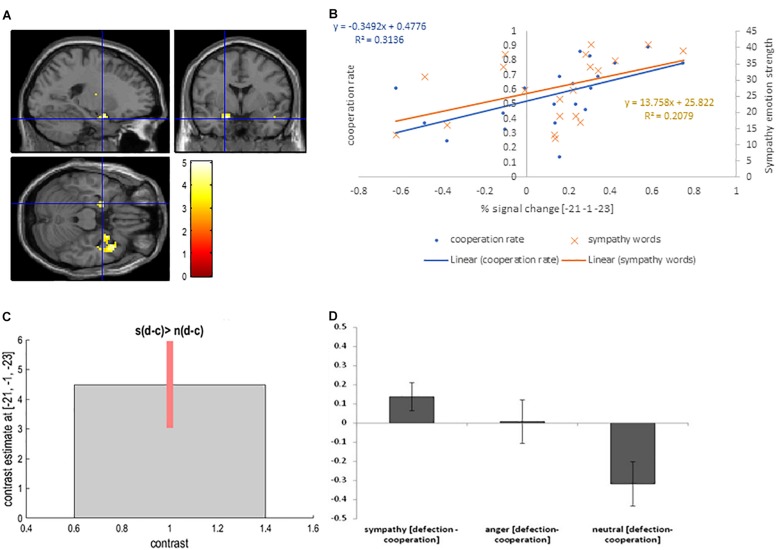
(A) Bilateral putamen activation overlaid on the MNI single subject template based on the interaction contrast [anger (defection – cooperation) – neutral (defection-cooperation)]; (B) Correlation between the interaction contrast percent signal change in the left putamen and the cooperation rate in the anger condition (blue) and correlation between the percent signal change in the left putamen and the strength of anger word rating in the anger condition (orange); (C) Contrast estimate and 90% Confidence Interval for interaction contrast; (D) Difference in percent signal change between defection and cooperation trials in sympathy, anger and neutral emotion condition for interaction contrast.